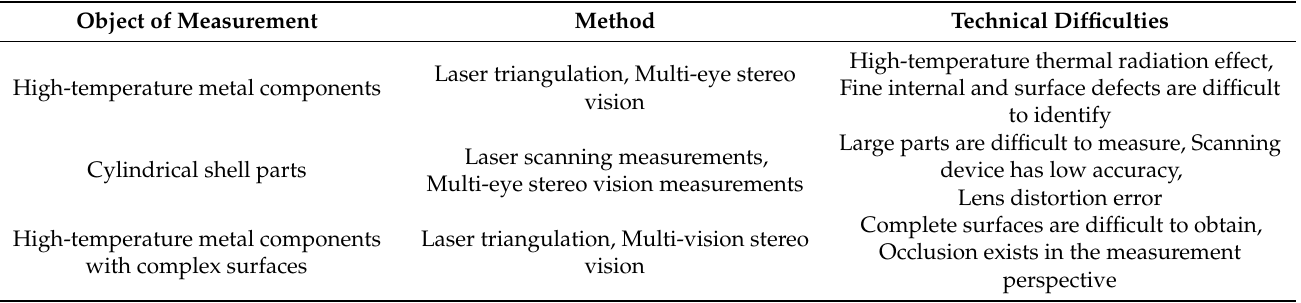
Table 10. Comparison of measurement